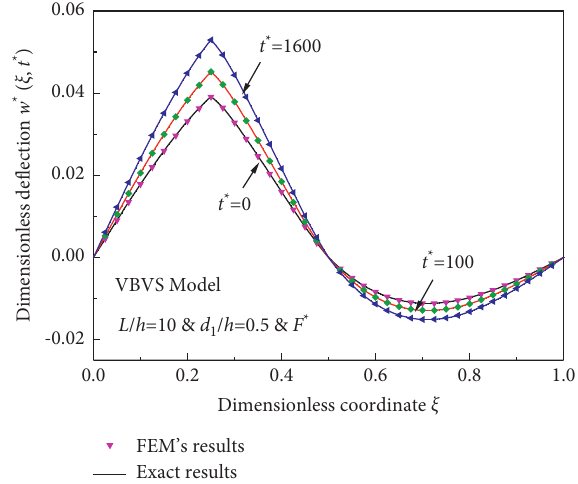
Figure 12: Distribution of dimensionless deflection w ∗ ( ξ , t ∗ ) versus dimensionless coordinate ξ of continuous viscoelastic cracked beam with VBVS